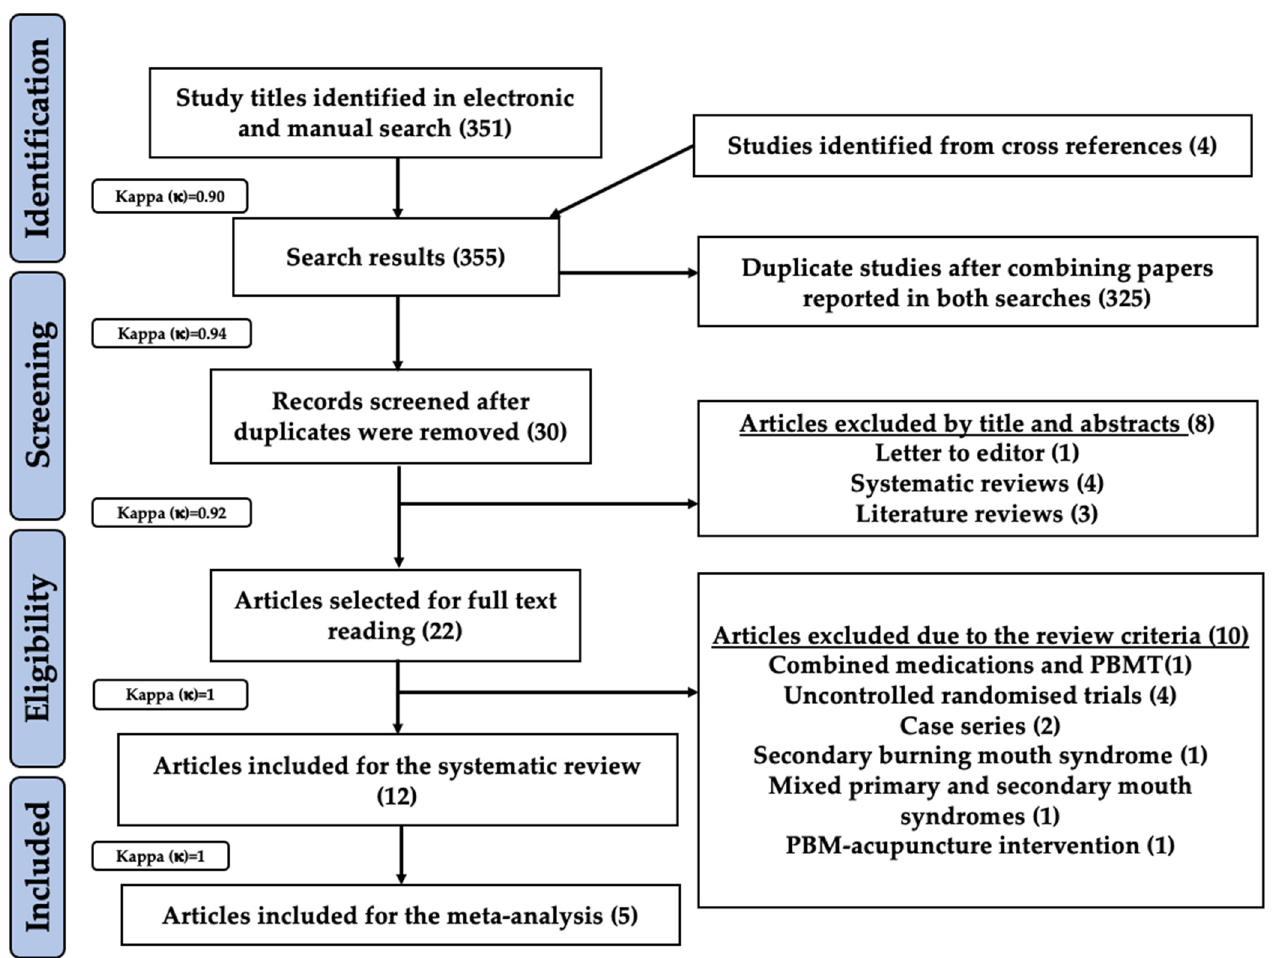
Figure 2. PRISMA flow-chart of selected criteria for the eligible articles.